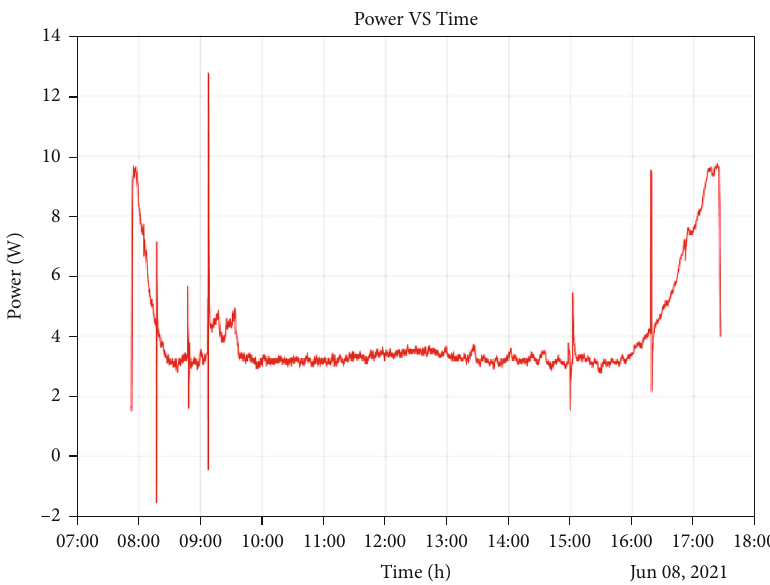
Figure 9: The di ff erence in power generation between DAST and